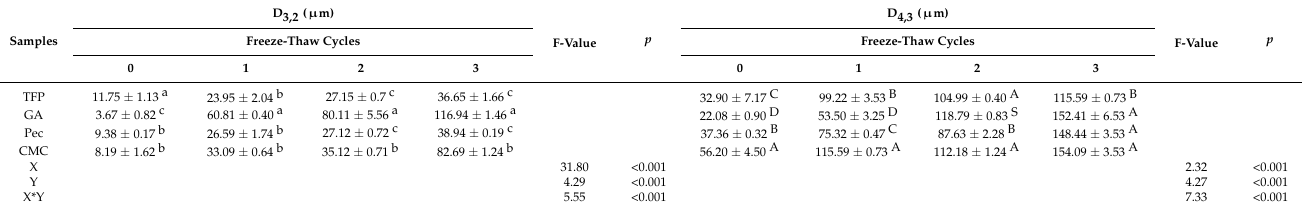
Table 1. Effect of freeze-thaw treatment on the particle size of different emulsions.